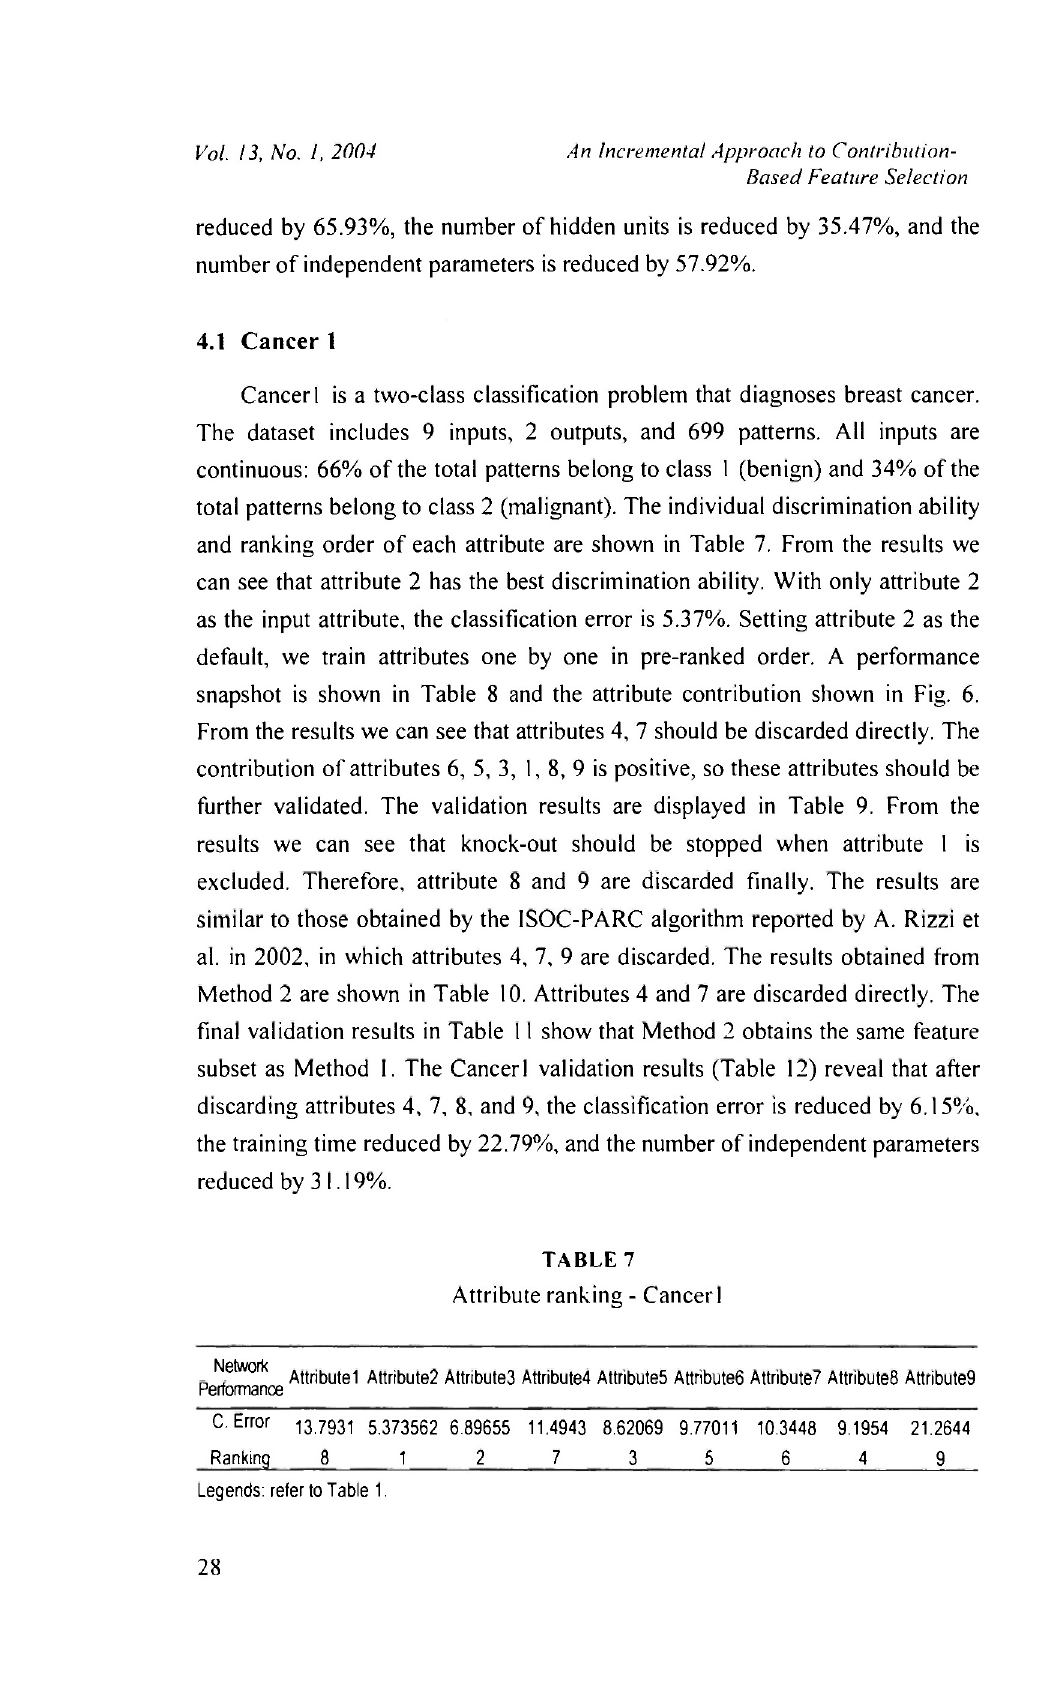
Legends: refer to Table 1.